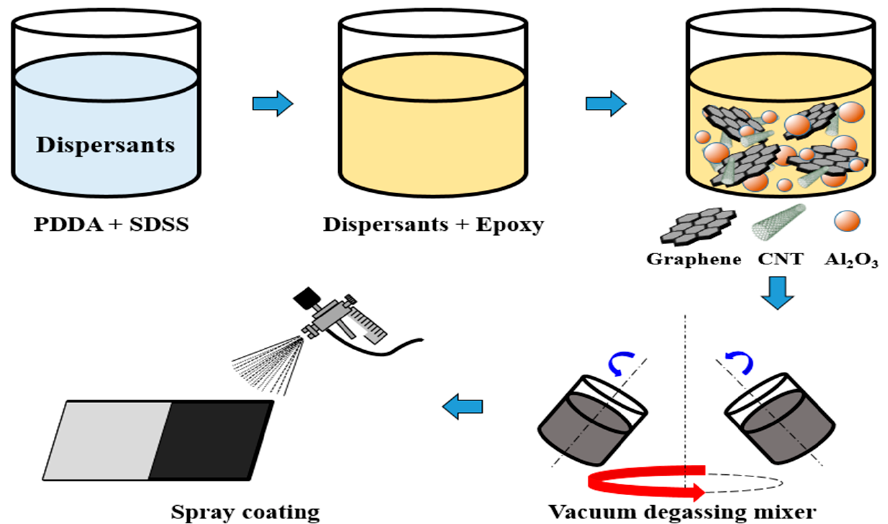
Figure 3. Preparation process of the graphene heat dissipation coating.